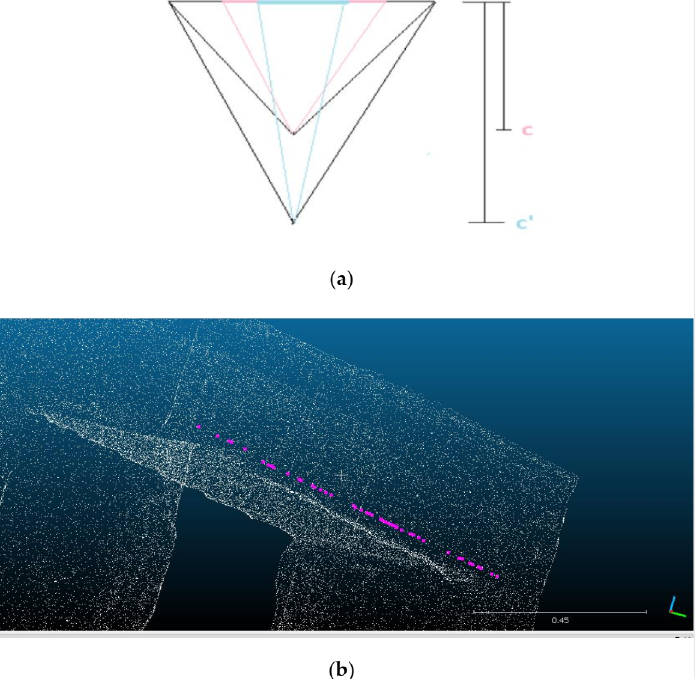
Figure 10. ( a ) The effect on the bundle of using the wrong focal length; ( b ) erroneous localization of 3D edge due to using nominal focal length.